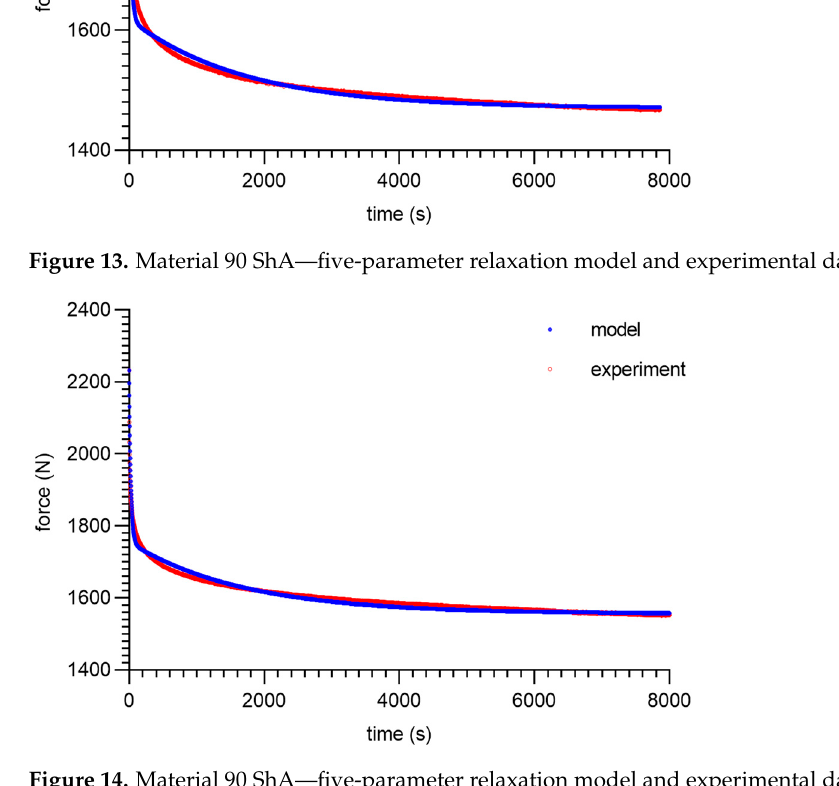
Figure 14. Material 90 ShA—five-parameter relaxation model and experimental data for ε = Figure 14. Material 90 ShA— fi ve-parameter relaxation model and experimental data for ε = 75% . Figure 14. Material 90 ShA— fi ve-parameter relaxation model and experimental data for ε = 75% . Figure 14. Material 90 ShA— fi ve-parameter relaxation model and experimental data for ε = 75% .